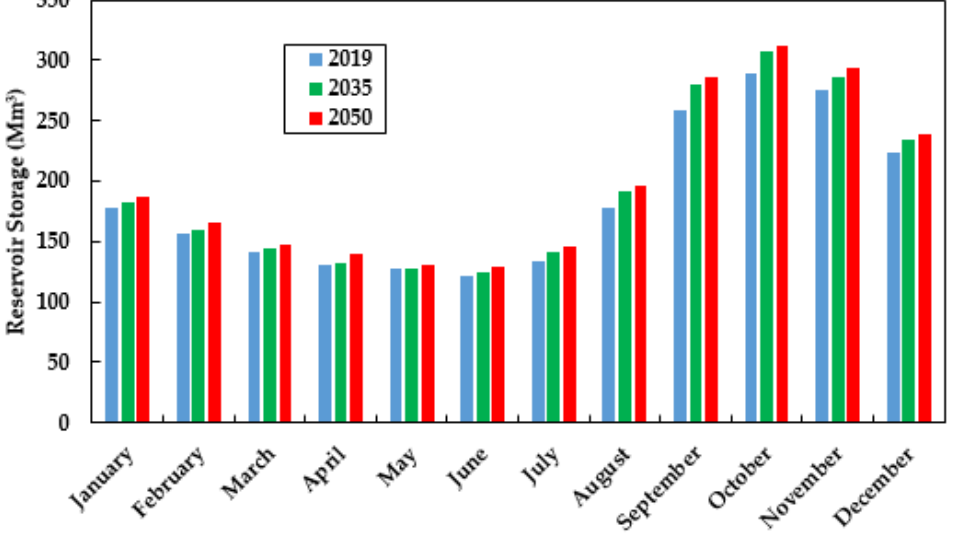
Figure 11. Average monthly current optimized and future reservoir storage of Nashe